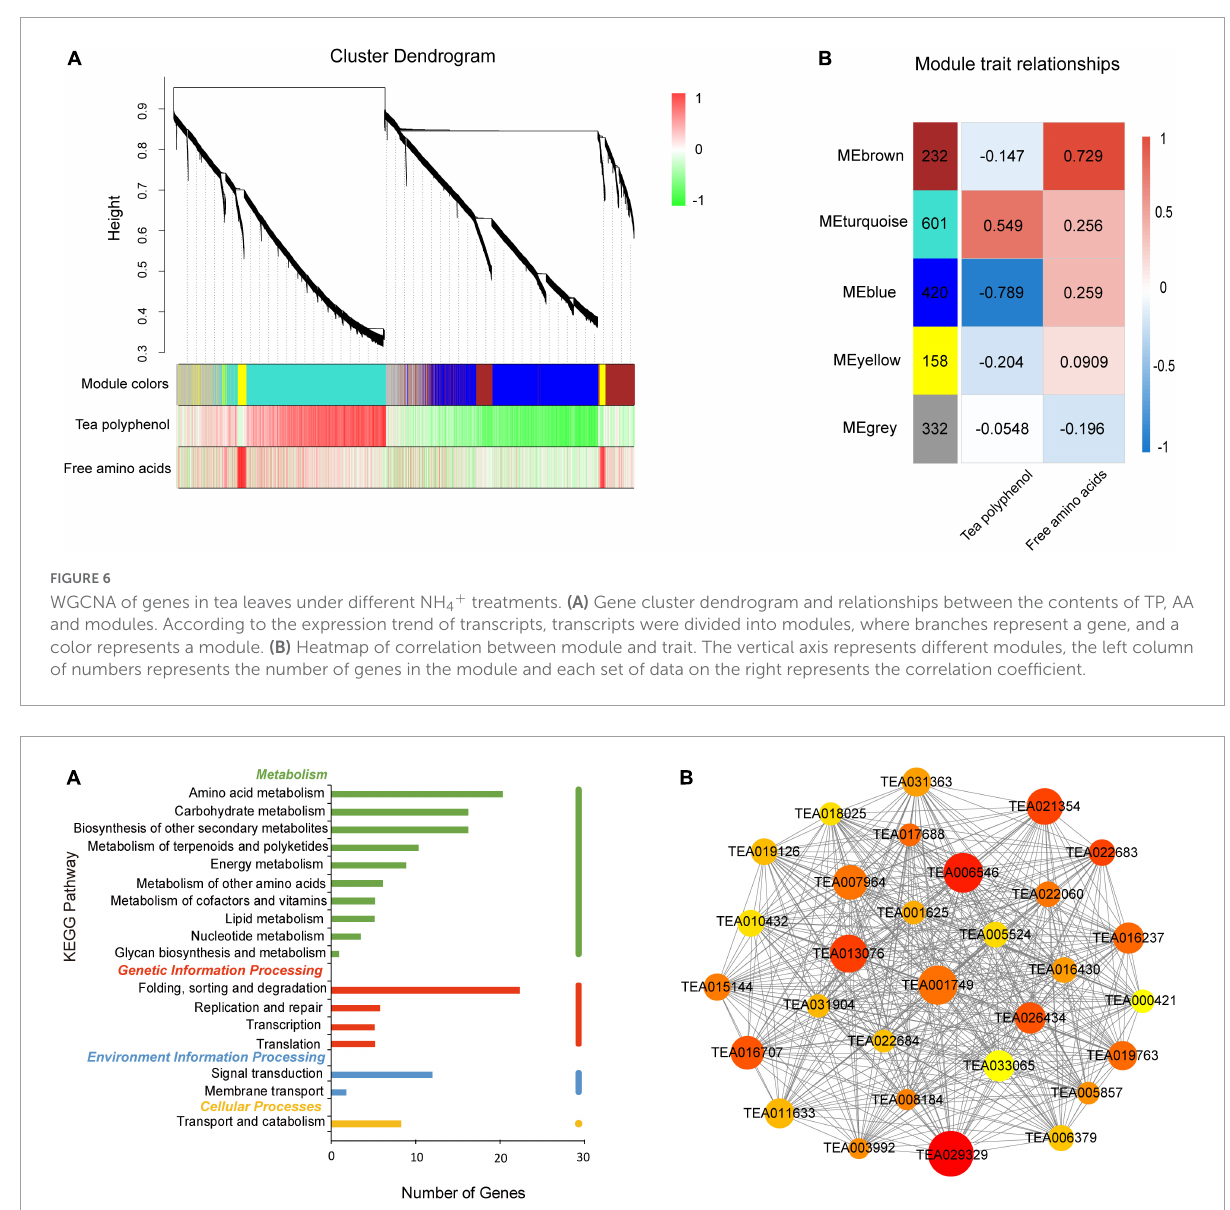
FIGURE7 KEGG pathway analysis and network diagram associated with the turquoise module. (A) KEGG pathway annotation of genes in the turquoise module. The genes with higher weight are shown in red, and the size of the node represents the number of genes associated with the node. (B) Gene networks of hub genes of the turquoise